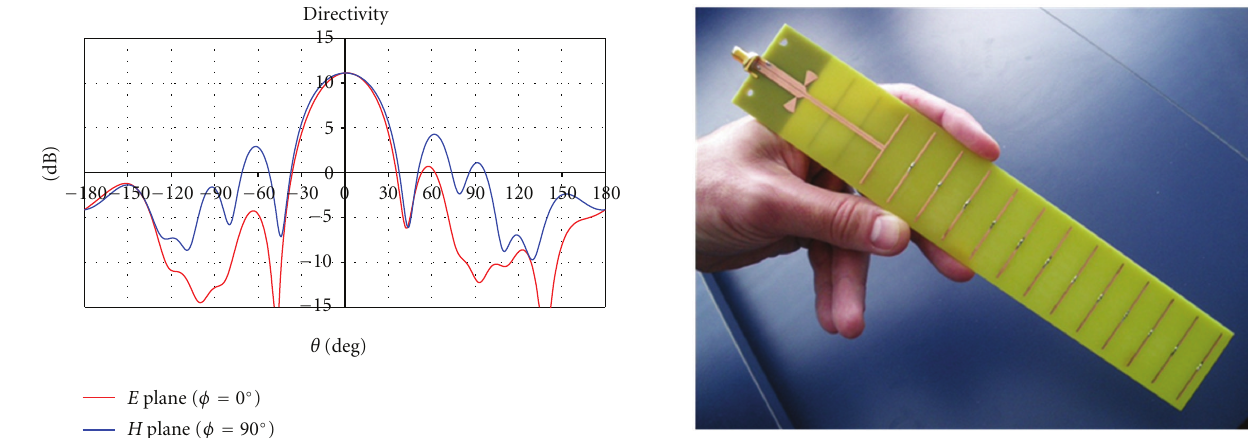
Figure 32: E - and H -plane cuts of the radiation pattern at 2.45GHz including realistic values of the SMD components. The realized gain (simulated) reaches 9.74dB (substrate and SMD ohmic losses).